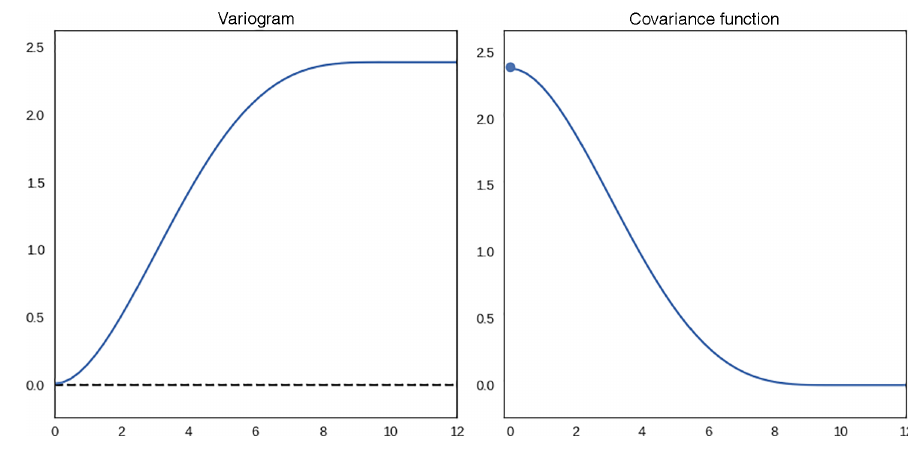
Figure D1. Representation of a cubic variogram and covariance for an arbitrary range and nugget